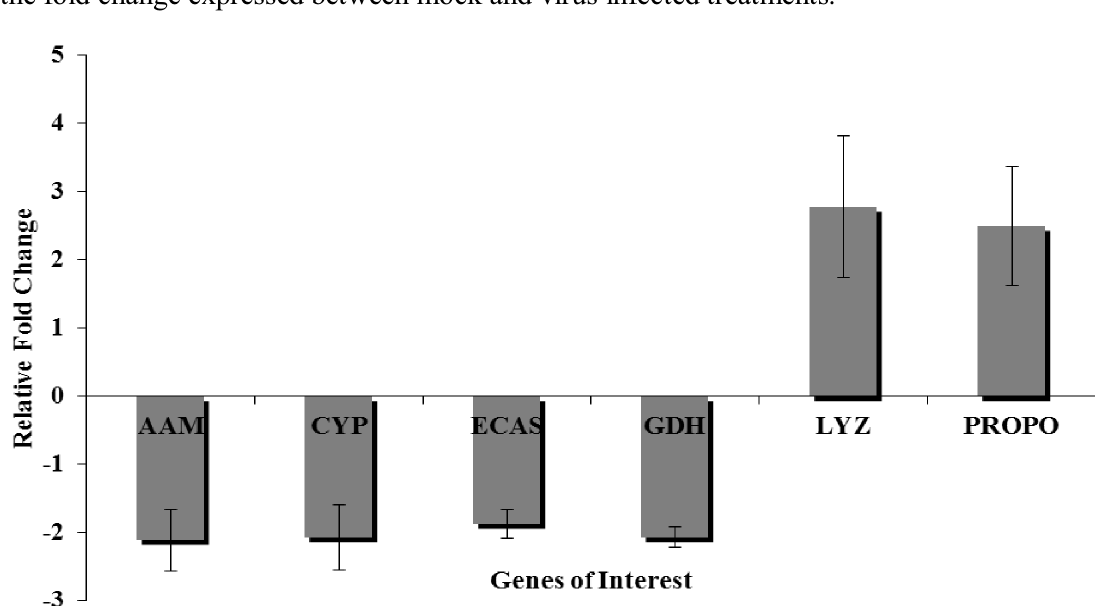
Figure 3. Relative fold changes (y-axis) in expression of alpha-amylase (AAM), cytochrome P450 (CYP), effector caspase (ECAS), glucose dehydrogenase (GDH), lysozyme (LYZ), and prophenoloxidase (PROPO). These data indicate the relationship between these genes and the fold change expressed between mock and virus infected